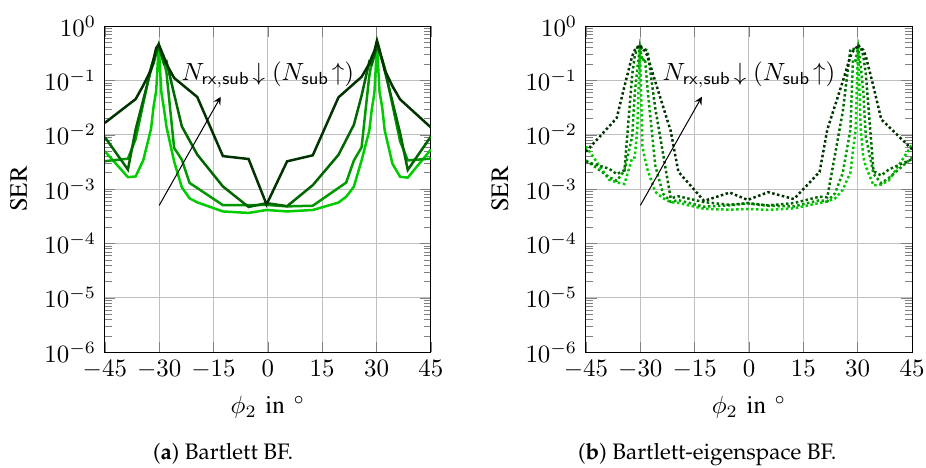
Figure 6. Symbol error rate vs. angle φ 2 of user 2 for the full-array system ( ) and for different sub-array configurations ( N sub = 4 and N rx , sub = 32 ( ), N sub = 8 and N rx , sub = 16 ( ), N sub = 16 and N rx , sub = 8 ( )).